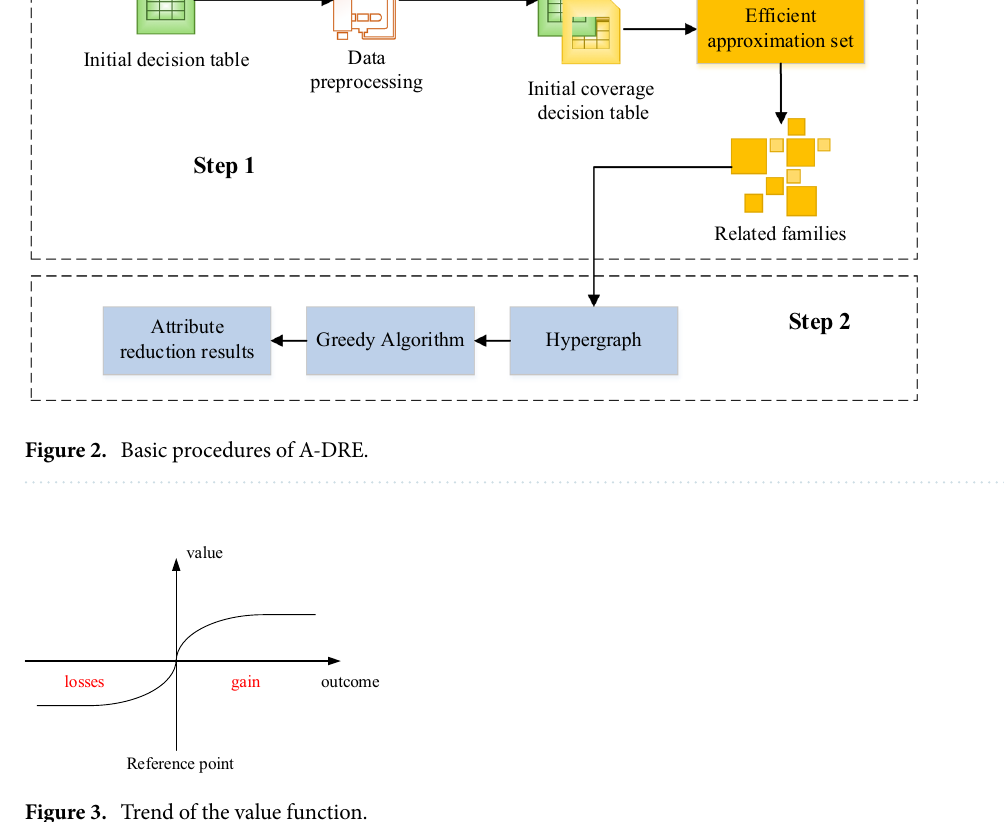
Figure 3. Trend of the value